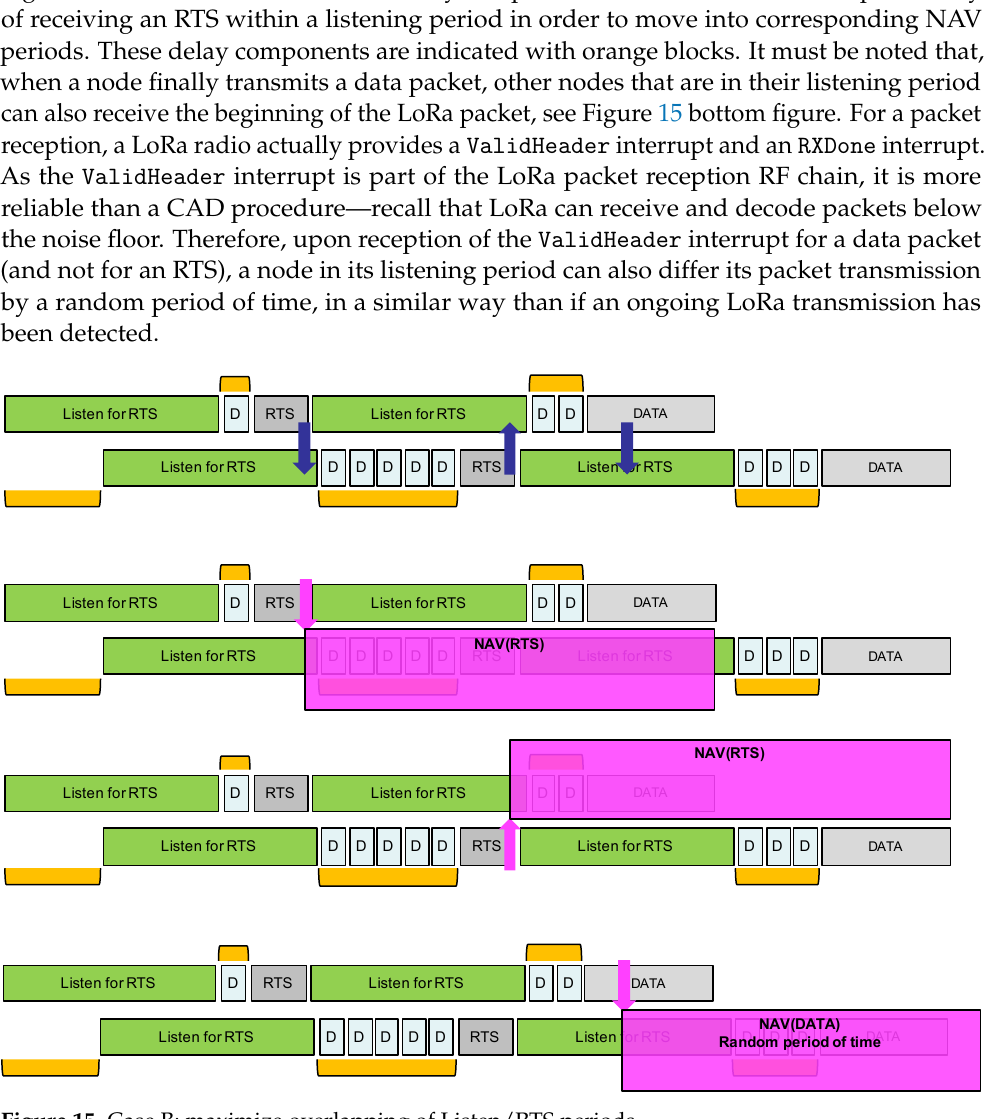
Figure 15. Case B: maximize overlapping of Listen/RTS